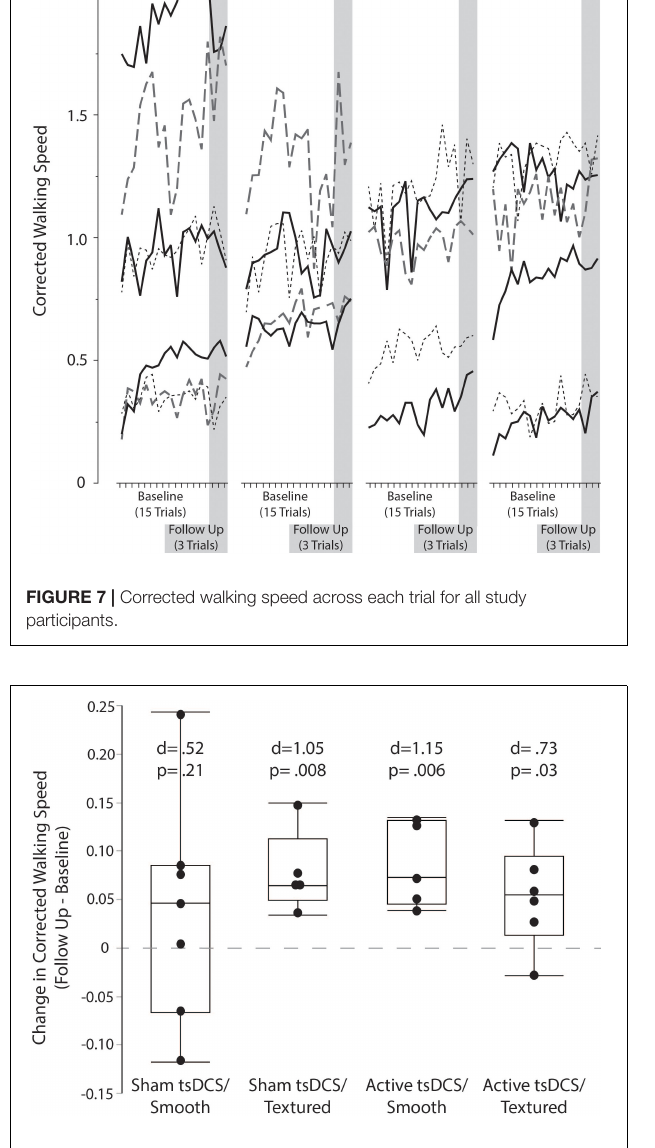
FIGURE 8 | Corrected walking speed. Box plots showing the change in corrected walking speed between the baseline and follow-up visits. For each participant, all trials were averaged within each session before calculating the change as follow-up minus baseline. The groups with active tsDCS and/or textured insoles showed larger and more consistent retention of performance than the control group (sham/smooth).